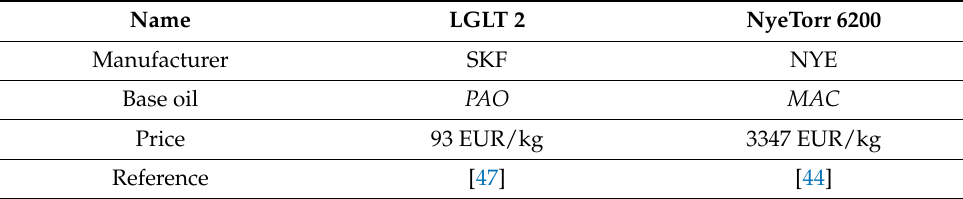
Table 8. Cost comparison of two greases suitable for FESS application.